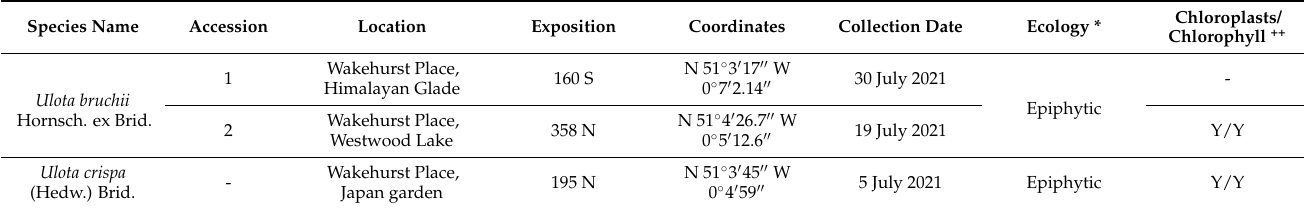
(a) indicates species used for germination tests, (b) indicates species used for DSC experiments. ++ chloroplast presence (Y) observed by light microscopy and chlorophyll presence (Y) detected by red autofluorescence in a fluorescent microscope. N indicates chloroplast or chlorophyll absence. * the terminology used for the descriptions of “Ecology” is adopted from [49] as follows: “Epiphytic”, when a species grows on trees, at diverse heights and/or preferring some positions around the tree itself, where growing on leaves the term changes to epiphyllous; “Saxicolous”, when a species grows on rocks or rocky substrata; “Terricolous”, said of a species growing on soil; “Terrestrial”, when a species grows both on soil and/or rocks and/or plants; “Aquatic”, when a species lives submerged or near streams, rivers or aquatic environments; “Ubiquitous”, when a species grows in different types of habitats and substrata, ranging from streams to branches of trees, from rocks to soil.